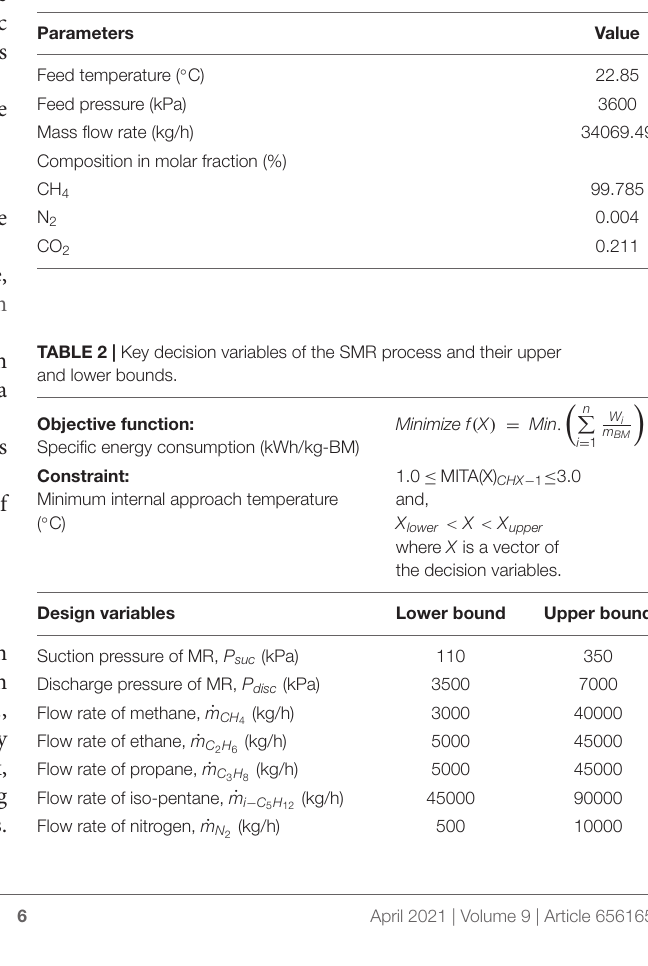
TABLE 1 | Conditions of the upgraded biomethane (Haider et al., 2020).